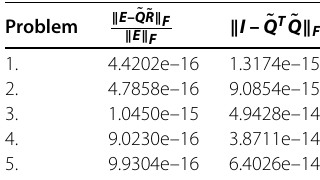
Table 3 Backward error analysis